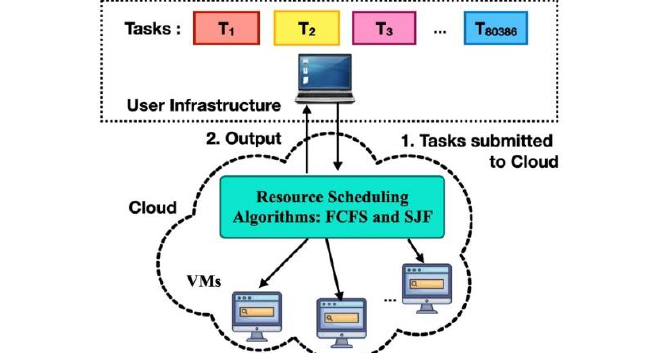
Figure 1. The flow of the Experiment